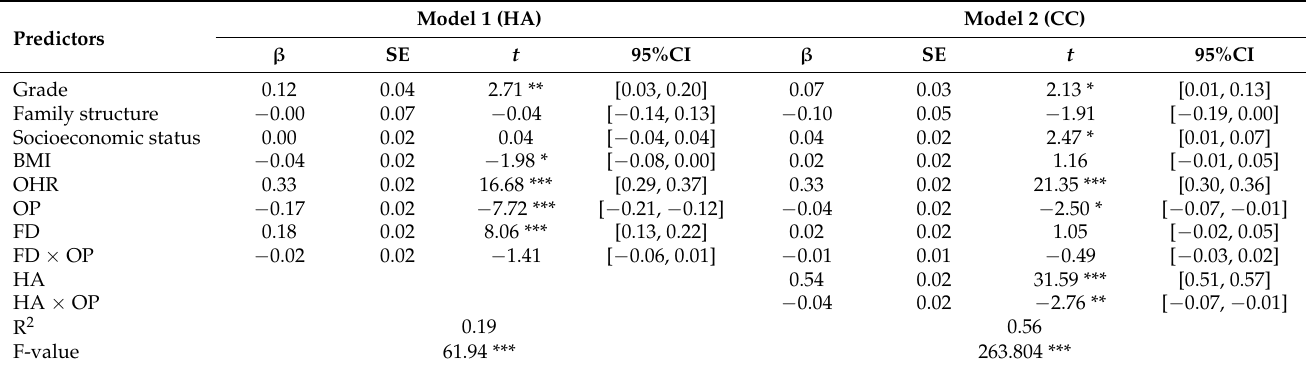
Table 4. Testing the Moderated Mediation Effect of Family Dysfunction on